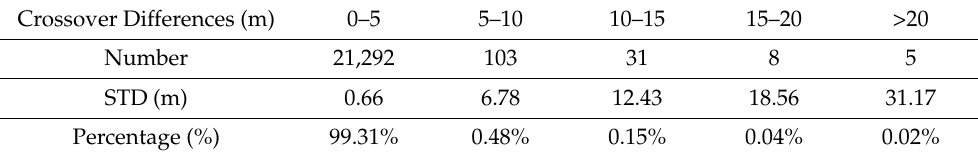
Figure 3. Distribution of crossovers in the study area. The pseudo-color image represents the range of crossover differences. Table 1. The range of crossover differences.